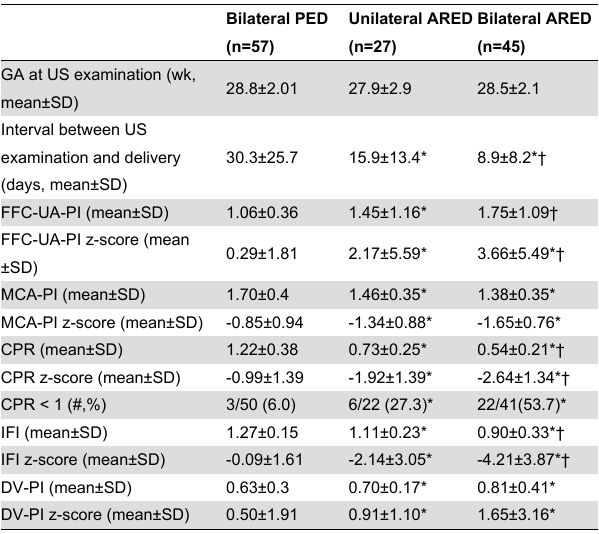
Table 4. Gestational age at US examination, interval between US examination and delivery, general hemodynamic characteristics depending on the degree of placental compromise.